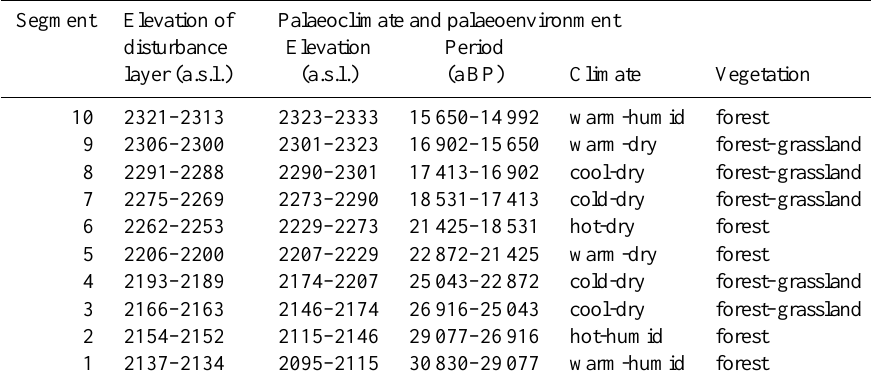
Table 1. The palaeoclimatic periods in the study area.